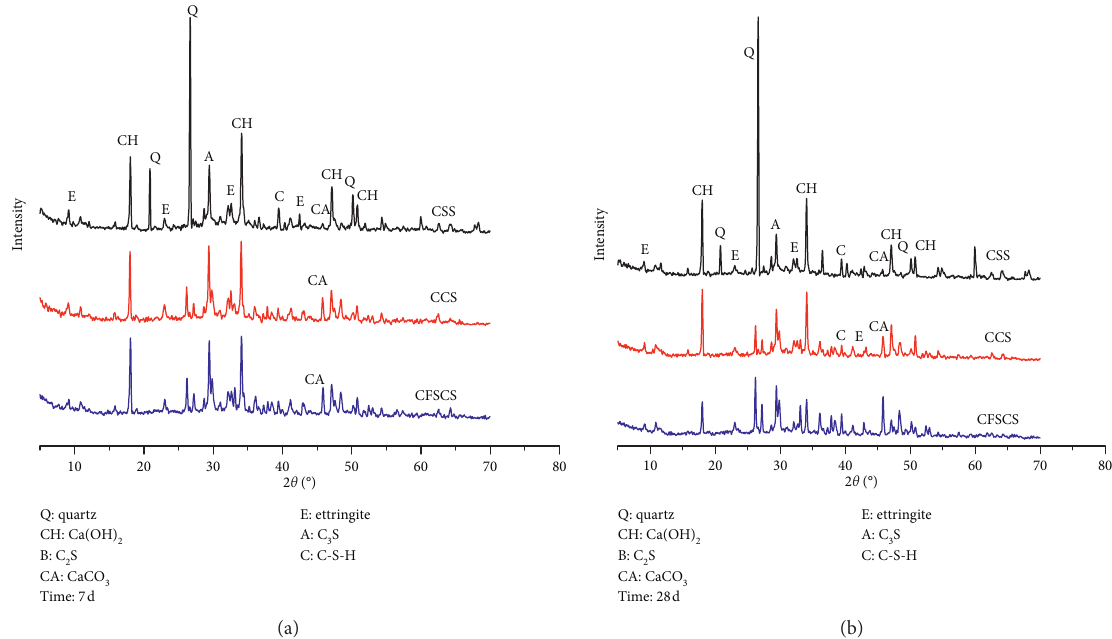
Figure 10: XRD analysis of mortar samples at (a) 7 d and (b) 28d. CSS: standard mortar; CCS: coral mortar; CFSCS: coral mortar with 15% fly ash and 15% slag.